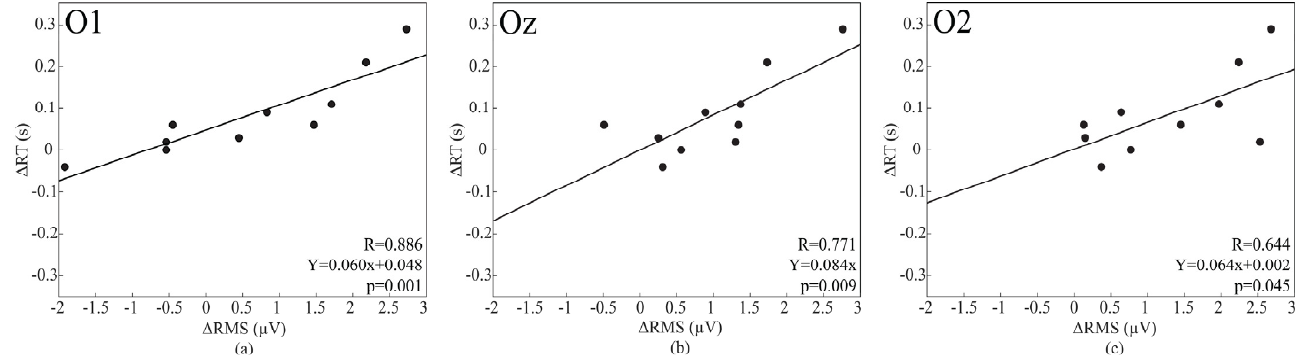
Figure 6. O1 ( a ), Oz ( b ), O2 ( c ): scatter plots, regression lines and corresponding Pearson’s correla- tion coefficients for the associations between changes induced by SD in the RMS of the baseline signal and those in RT. Circles represent single participant and the continuous lines correspond to the regression line of all the plotted points.